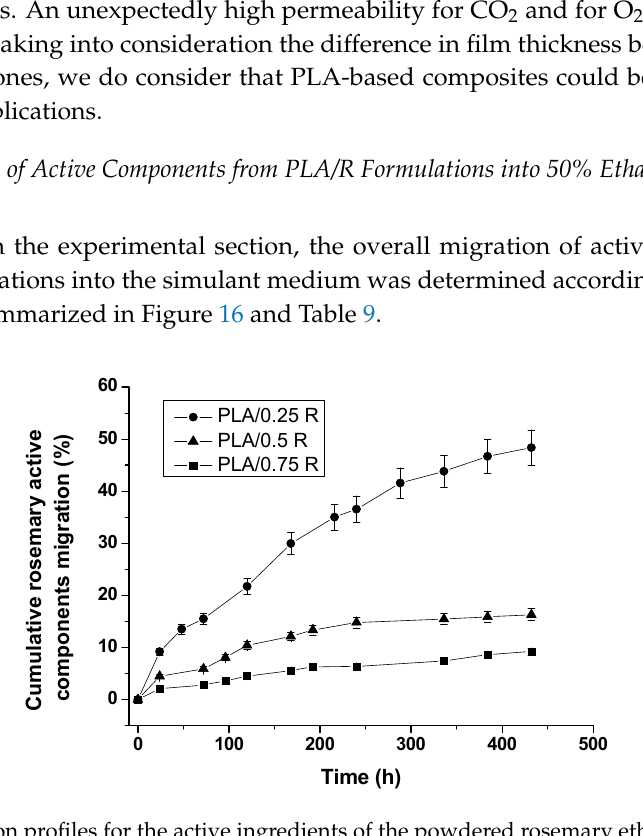
Figure 16. Migration profiles for the active ingredients of the powdered rosemary ethanolic extract (R) from PLA-based samples into 50% ethanol solution as a food simulant medium.